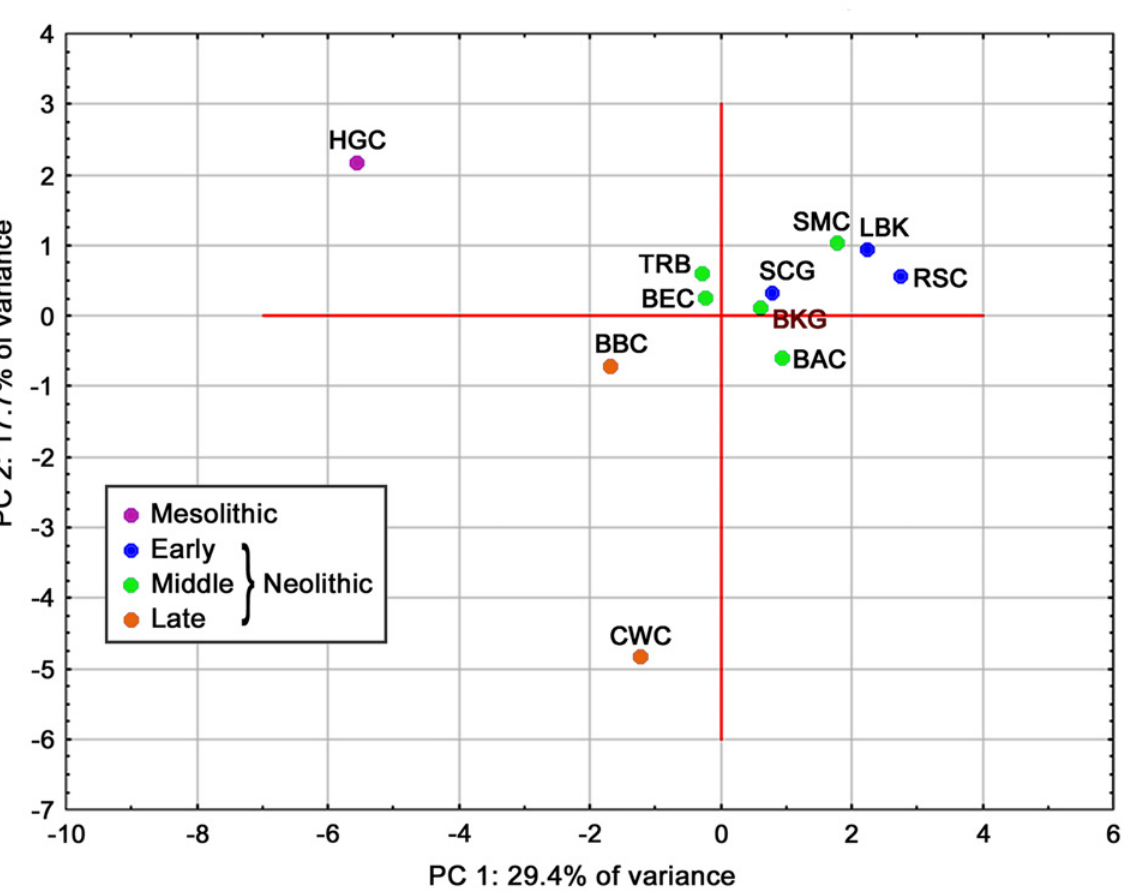
Fig 3. Plot of the first two principal co-ordinates illustrating patterns of affinity between the analyzed populations based on frequencies of mtDNA haplogroups (TRB — Funnel Beaker Culture; other abbreviations for Mesolithic and Neolithic cultural units as in the footnote of Table